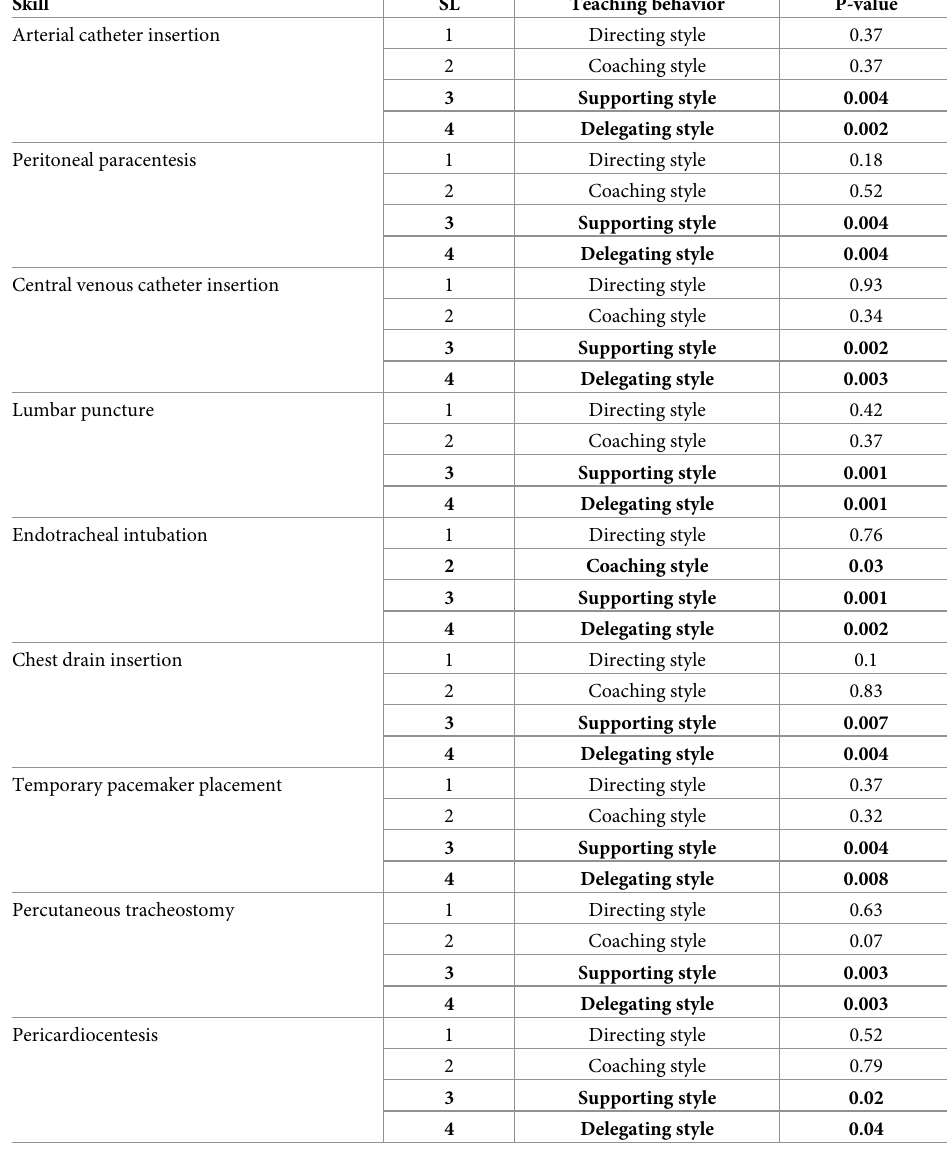
Table 7. Comparison of repetitions for supervision level and perceived teaching